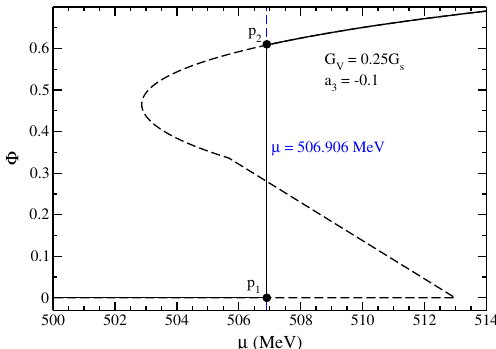
Fig. 3 Ω PNJL0 as a function of the quark chemical potential ( μ ) for G V = 0 . 25 G s and a 3 = − 0 . 1